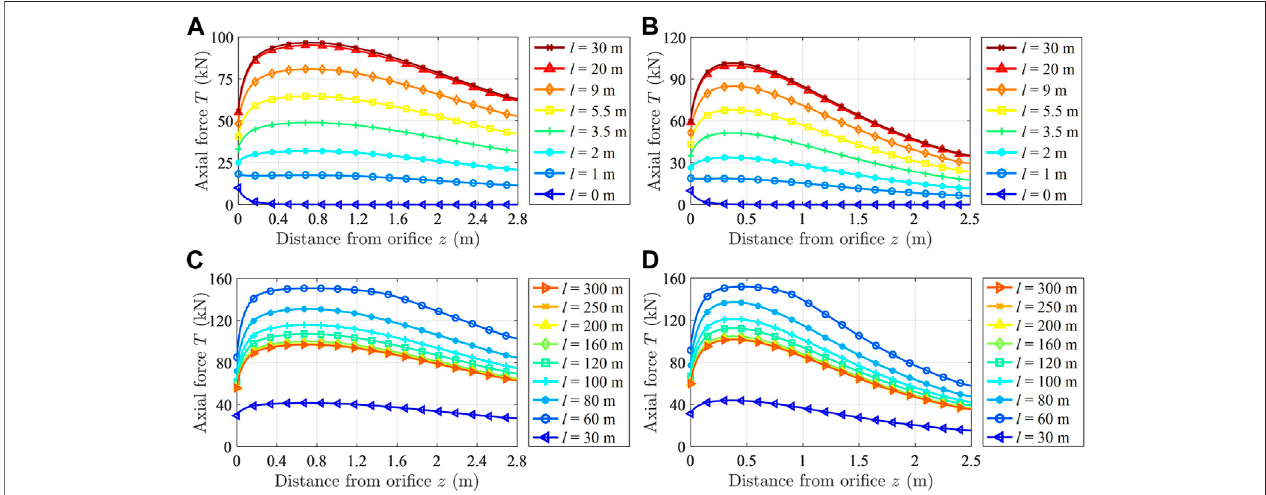
FIGURE 10 | Distribution law of the axial force of the bolt with the bolt body: (A) Variation law of the axial force of bolt A with the advance of the driving face; (B) Variation law of the axial force of bolt B with the advance of the driving face; (C) Variation law of the axial force of bolt A with the advance of the working face; and (D) variation law of the axial force of bolt B with the advance of the working face.